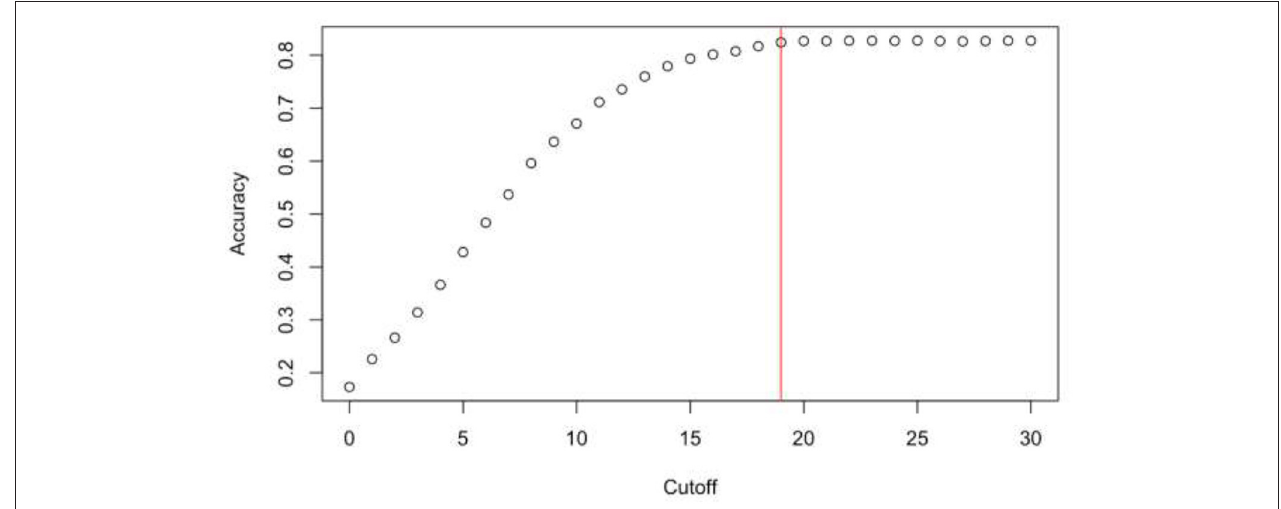
FIGURE 3 | Accuracy as a function of threshold